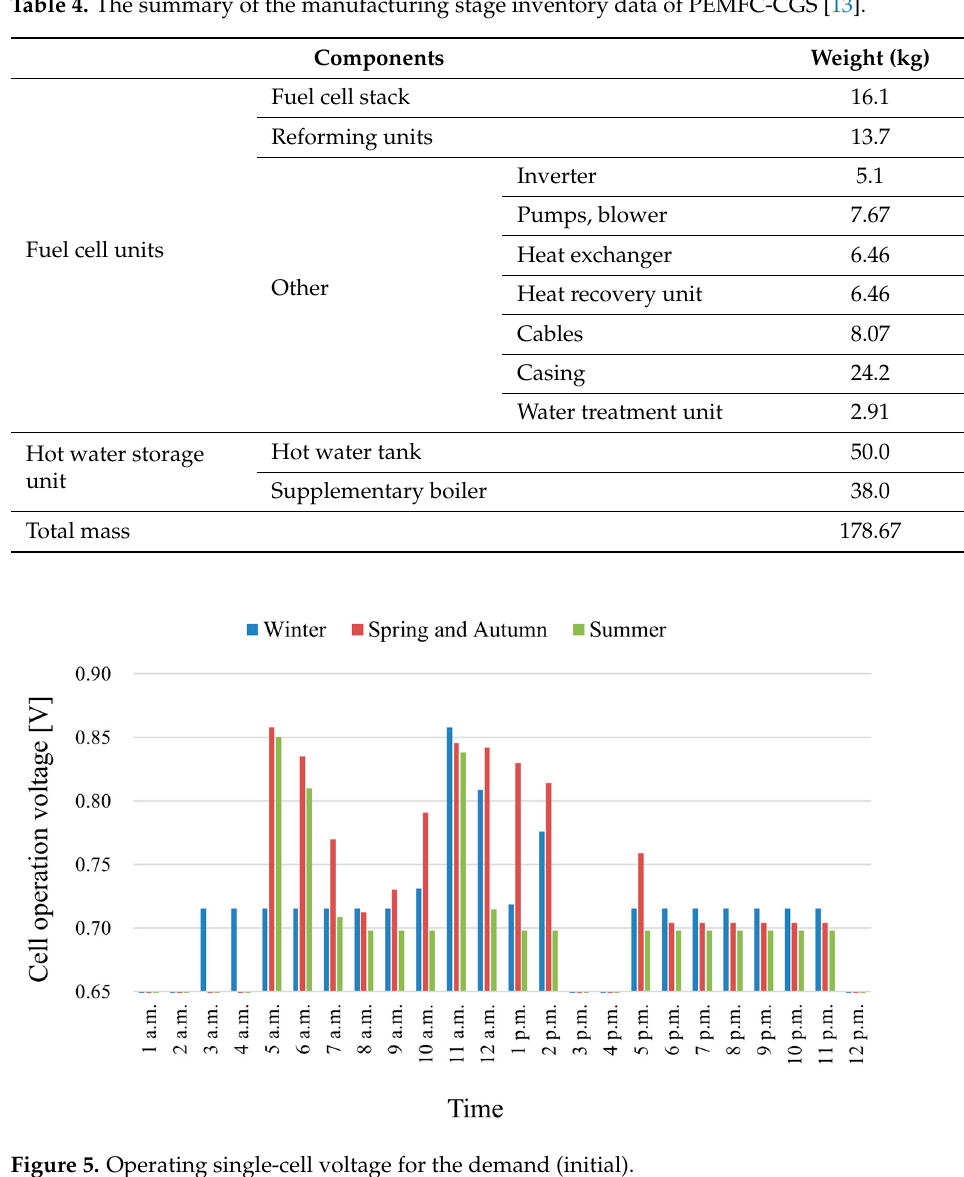
Table 4. The summary of the manufacturing stage inventory data of PEMFC-CGS [13].